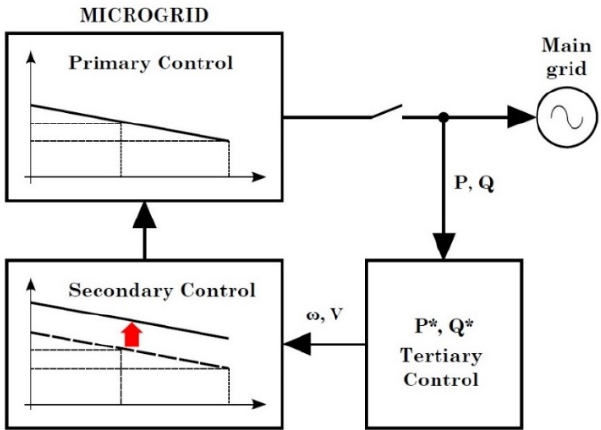
Figure 3. Primary, secondary and tertiary control loops.